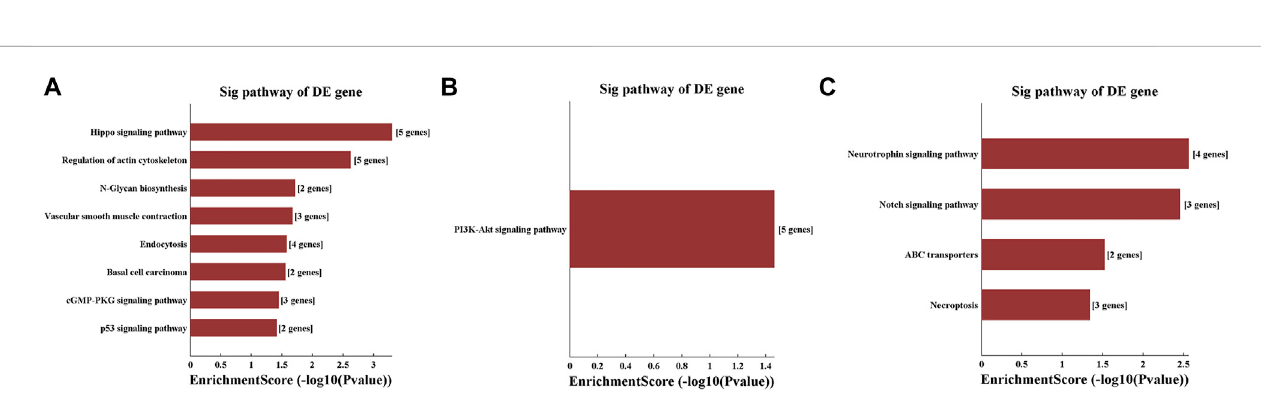
KEGG pathway analysis shows the related pathways changed signi fi cantly after methamphetamine self-administration. KEGG pathway analysis for potential target genes of (A) tiRNA-1-34-Lys-CTT-1, (B) tRF-1-16-Ala-TGC-4 and (C) tRF-1-32-Gly-GCC-2-M2. The vertical axis shows the annotated functions of the target genes. The horizontal axis shows the enrichment score (-log10 ( p -value)) and the gene number of each cluster. KEGG: Kyoto Encyclopedia of Genes and Genome, DE: differently